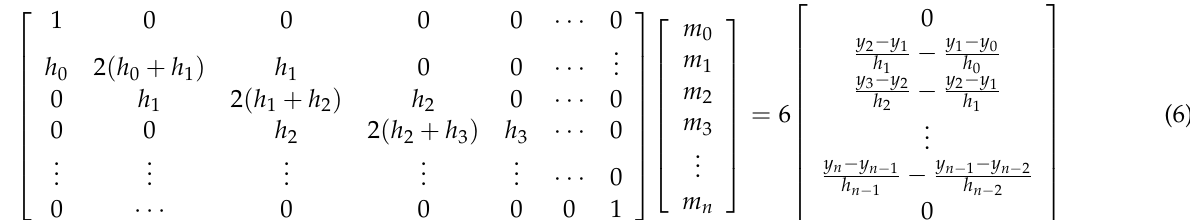
Figure 9. Verification of established finger bending model. ( a ) Hand gesture of 1. ( b ) Hand gesture of 2. ( c ) Hand gesture of 3. ( d ) Hand gesture of 4. ( e ) Hand gesture of 5. ( f ) Hand gesture of 6. ( g )